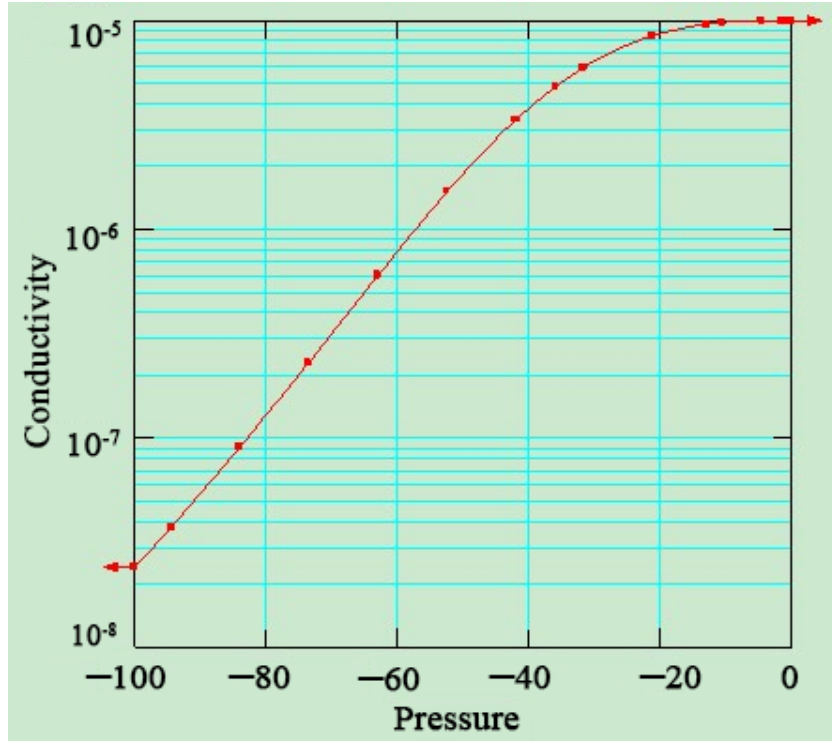
Figure 7. Hydraulic conductivity function at a permeability coefficient of 1.9 × 10 −4 m/s.